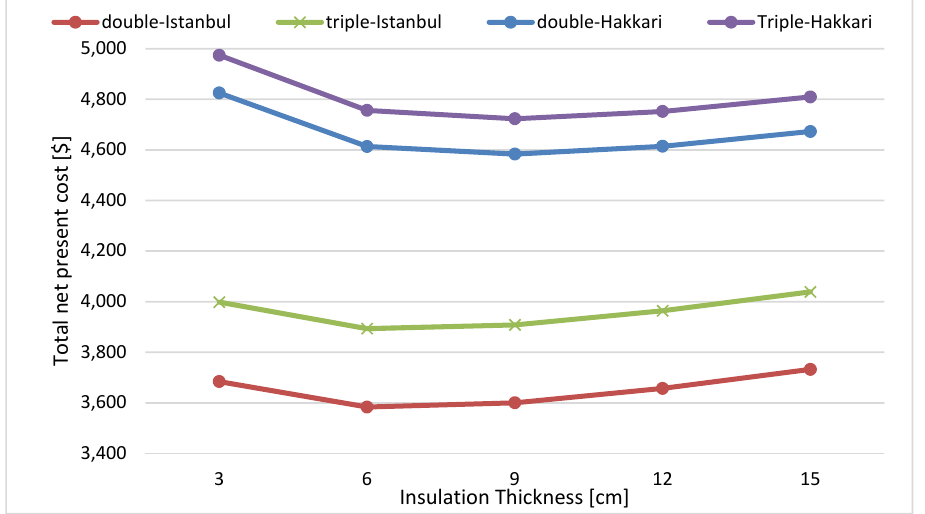
Figure 11. The influence of insulation thickness on the net present cost (40% WWR, NW oriented façade) for the selected locations .